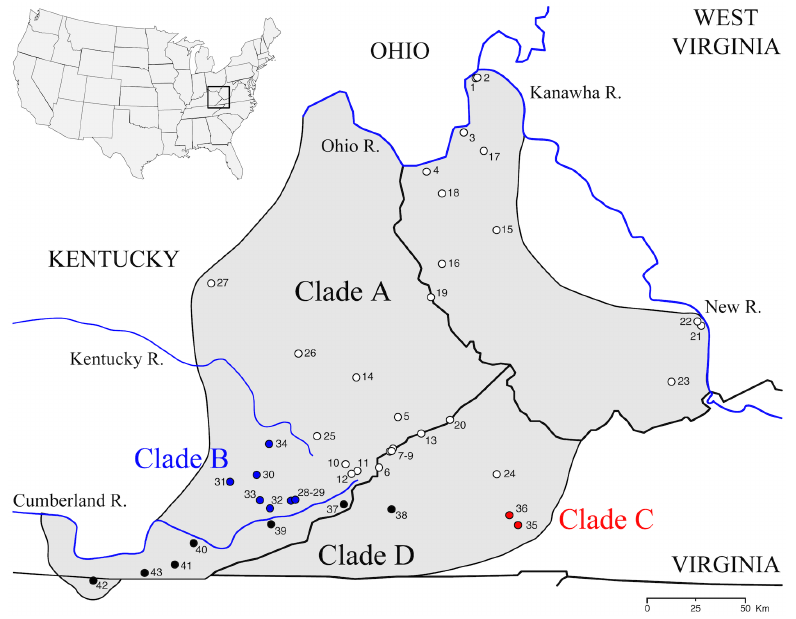
Fig 1. Map of the range of Plethodon kentucki . Sample localities are numbered, and match Fig 3 and S1 Appendix. Symbols identify the mtDNA clade of individuals in that population (Fig 3).